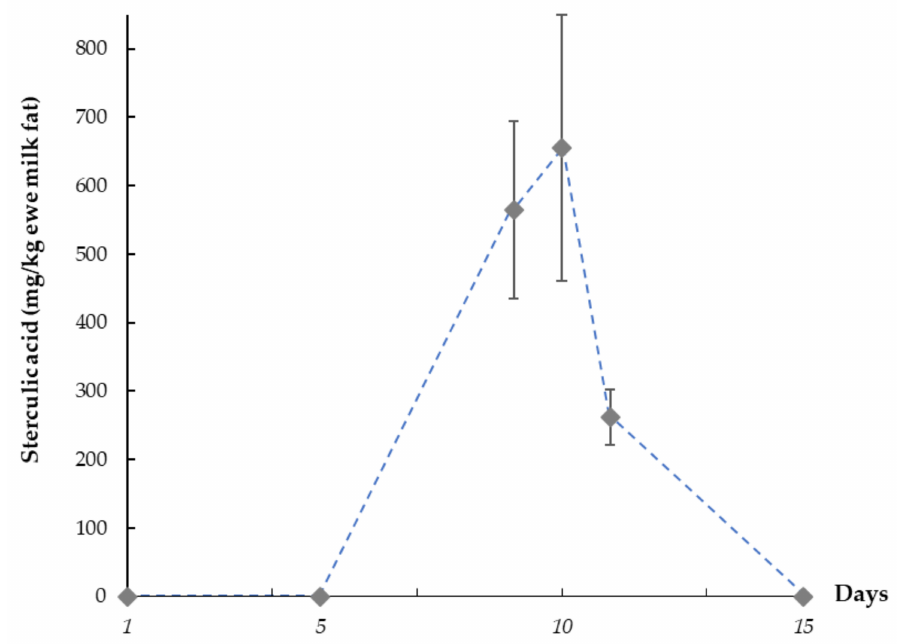
Figure 5. Sterculic acid trend in ewe milk fat over time. Pre-treatment: day 1 to 5; Treatment (0.5 g / day of sterculic acid by jugular infusion): day 6 to 10; Post-treatment: day 11 to 15. Values are reported as mean concentration (mg / kg total fat) of all samples ( n = 6) at each chosen timepoint: 1st day pre-treatment; 5th day pre-treatment; 4th day-treatment; 5th day-treatment; 1st day-post-treatment; 5th day-post-treatment. Bars indicate standard deviation (as inter-subjects